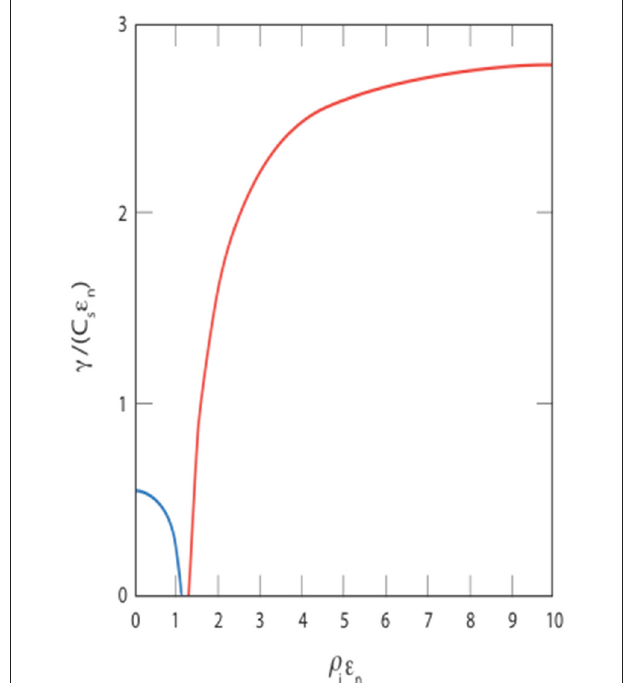
FIGURE 3 | Calculated growth rate of the usual Rayleigh-Taylor instability (blue curve) and the Large Larmor Radius Rayleigh Taylor instability (red curve) as a function of ρ i ε n . Solutions come from solving set of single fluid MHD Equations (blue curve) with the addition of the Hall term (red curve). The figure is redrawn from the original Figure 1 in Hassam and Huba (1987), with permission from The American Geophysical